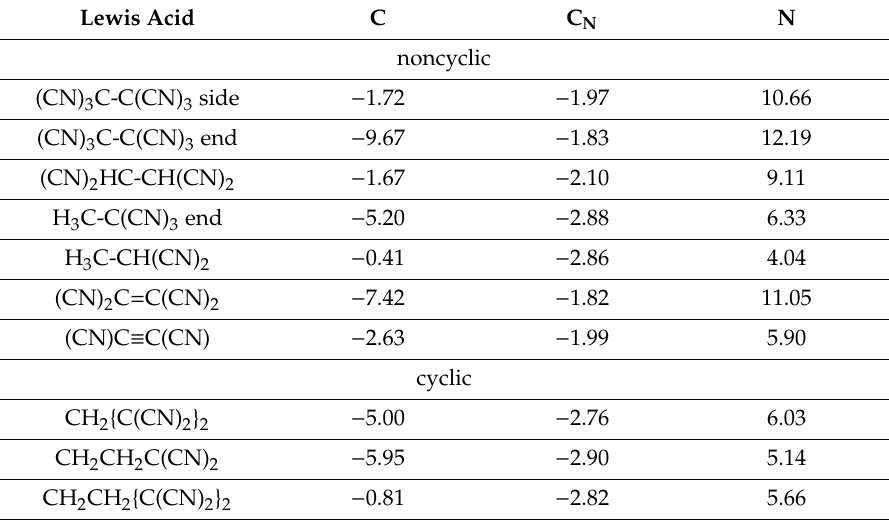
Table 4. Changes in NMR chemical shielding a (ppm) caused by complexation with NH 3 . Lewis Acid C C